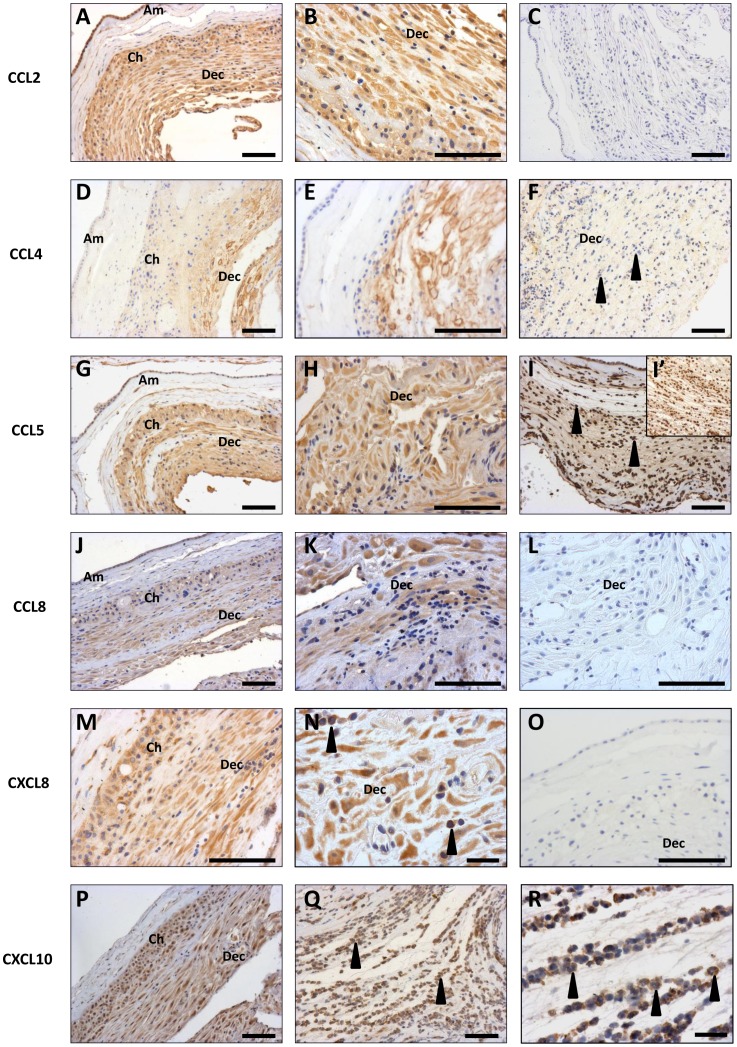
Localisation of chemokine proteins in fetal membranes.Representative images taken at original magnification of x10 or x20 for: (A–C) CCL2, (D–F) CCL4, (G–I) CCL5, (J–L) CCL8, (M–O) CXCL8, (P–R) CXCL10. Representative negative controls shown for CCl2 (C), CCL8 (L) and CXCL8 (O). Inset in Fig. I (I’) is a serial section immunostained for neutrophil-elastase (neutrophil marker) as decrsibed in [12], demonstrating the similarity between CCL5/CXCL10 immunostaining and neutrophil abundance in PTLI samples. Am = amnion, Ch = chorion, Dec = decidua. Arrow heads indicate cells with the morphologically appearance of leukocytes. All scale bars are 100 µm, except Figs N and R where they are 25 µm.